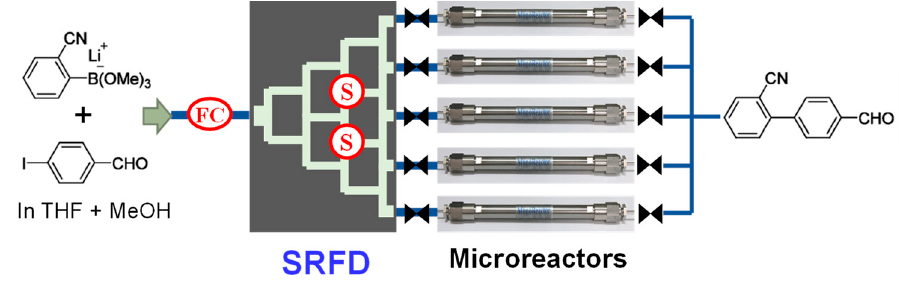
Figure 6. Numbering-up system with split-and-recombine-type flow distributor (SRFD).